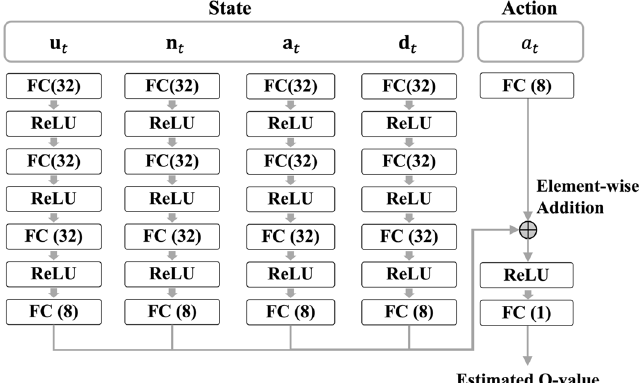
Fig. 6 The architecture of the DNN in